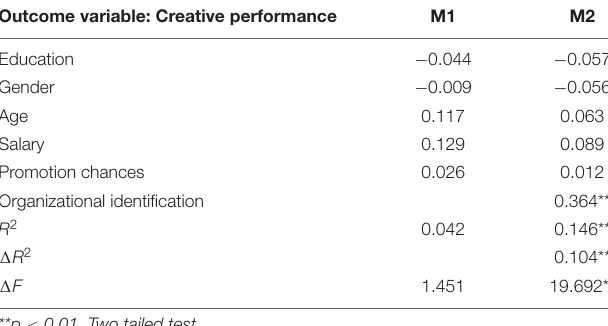
TABLE 4 | The effect of organizational identification on creative performance.